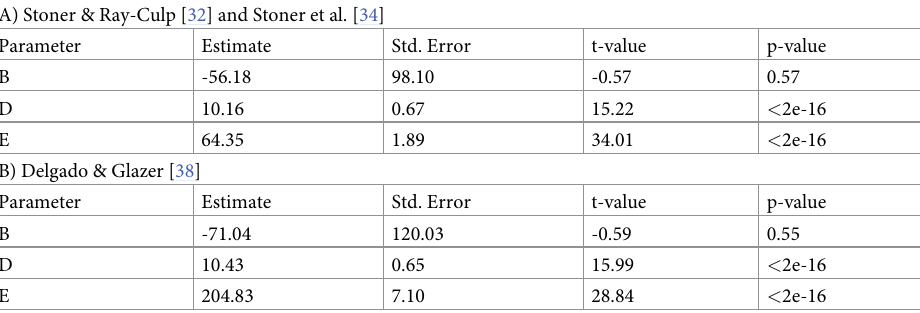
Table 2. Dose-response logistic regression model fit